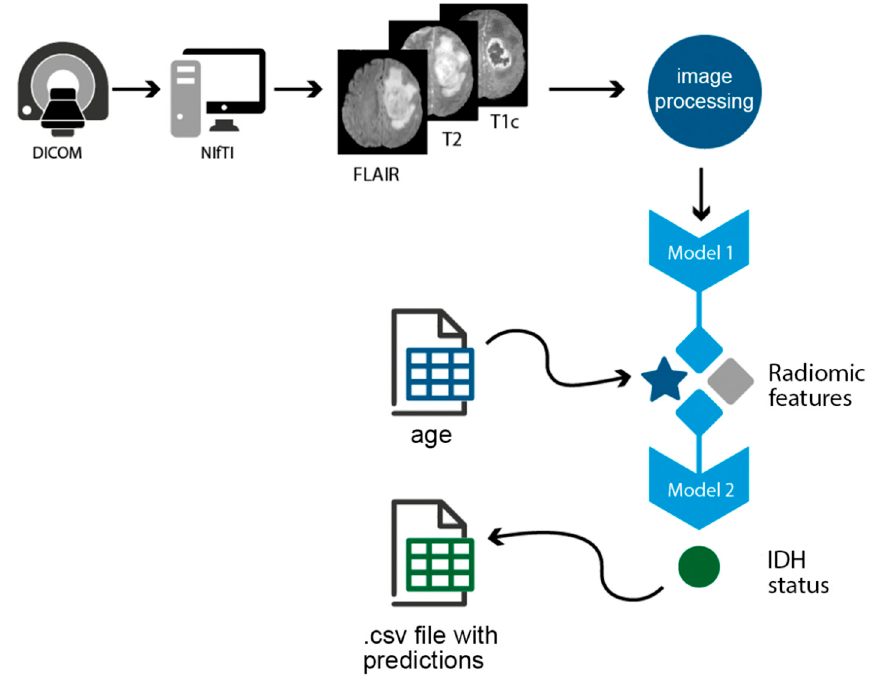
Figure 3. The pipeline of the python script that automated the testing. Abbreviations: DICOM, Digital Imaging and Communications in Medicine; NIfTI, Neuroimaging Informatics Technology Initiative; FLAIR, fluid-attenuated inversion recovery; T1c, T1 contrast enhanced; csv, Comma Separated Values; IDH, isocitrate dehydrogenase.